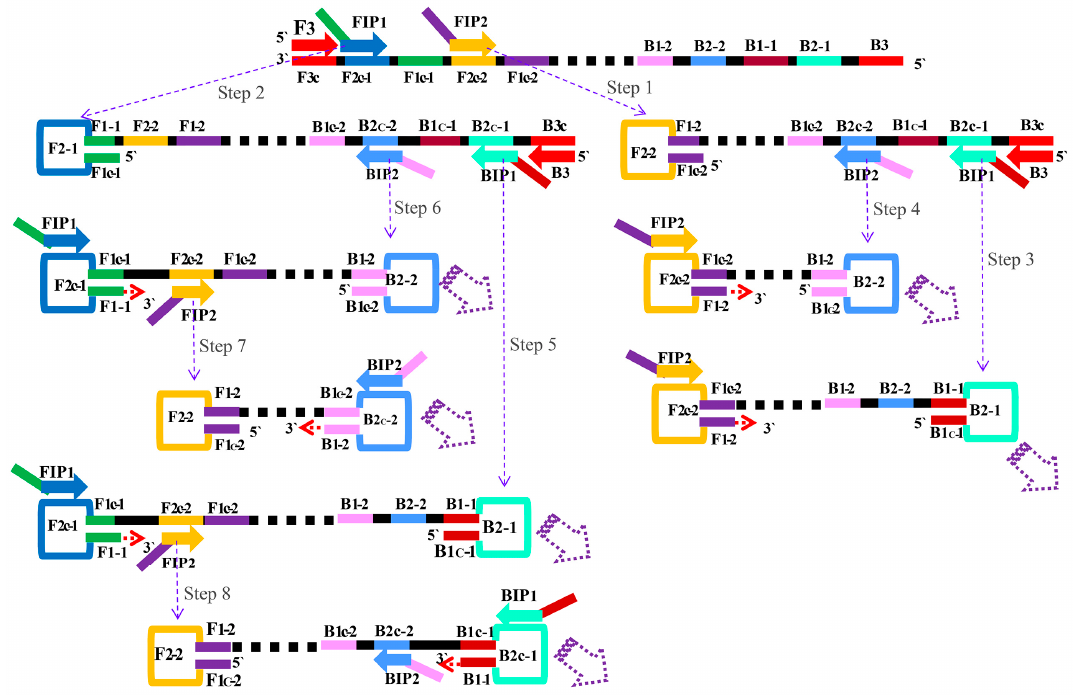
Figure 1. The principle of MIP-LAMP amplification. The schematic showing the mechanism of the novel MIP-LAMP assay.